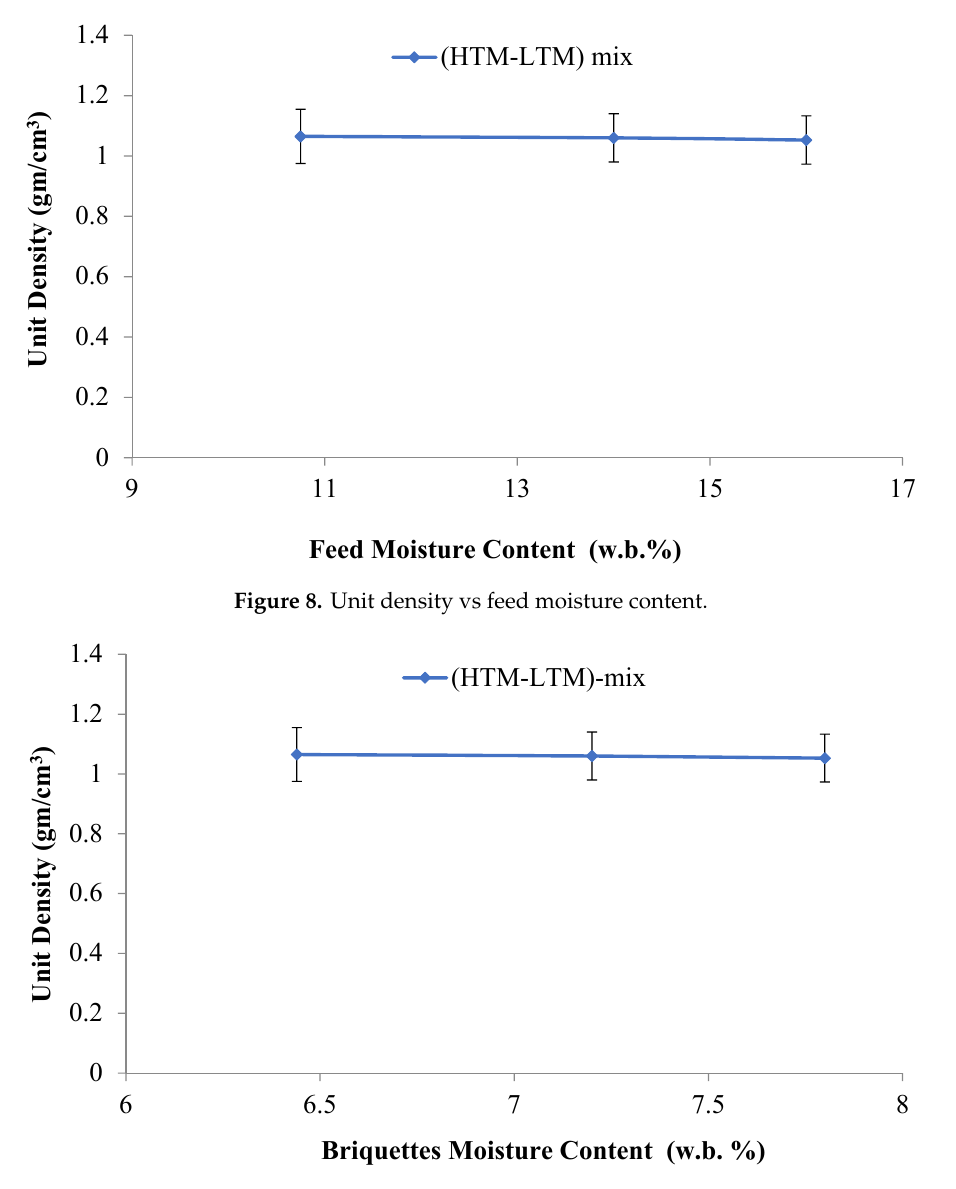
Figure 9. Impact of briquette moisture content on the bulk density.